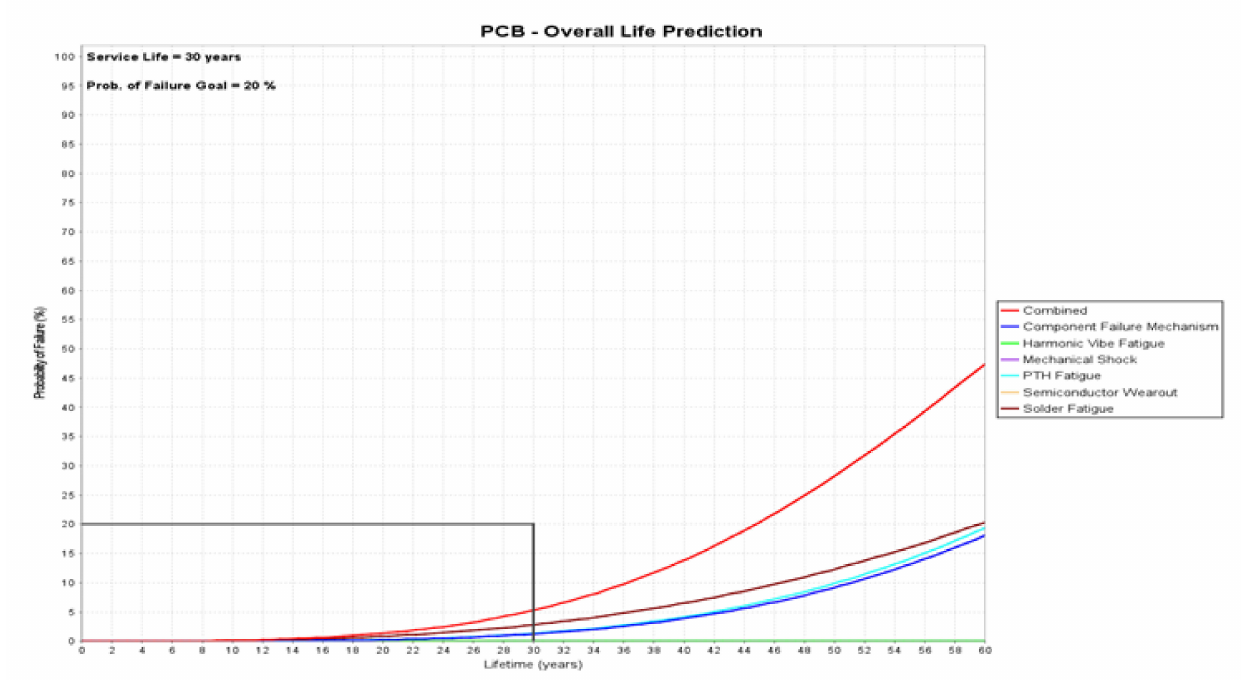
Figure 18. Overall assessment of the operational lifetime of the power